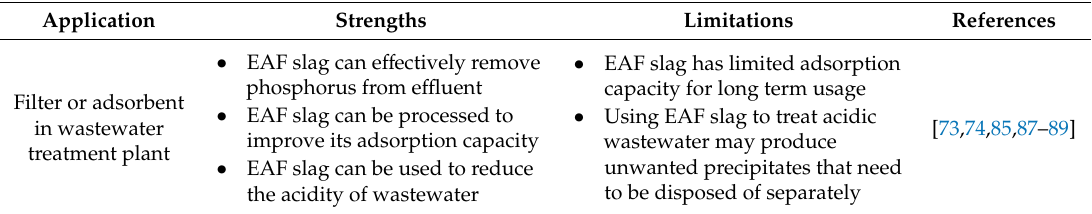
Table 6. Strengths and limitations of incorporating EAF slag in filter or adsorbent in wastewater treatment